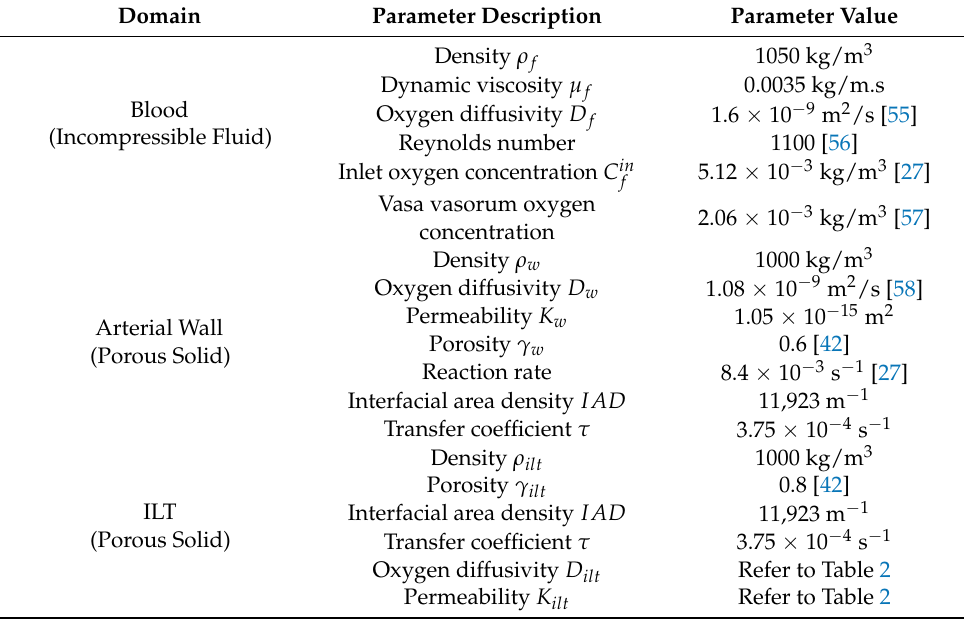
Table 1. Physical and compositional parameters for AAA domains.